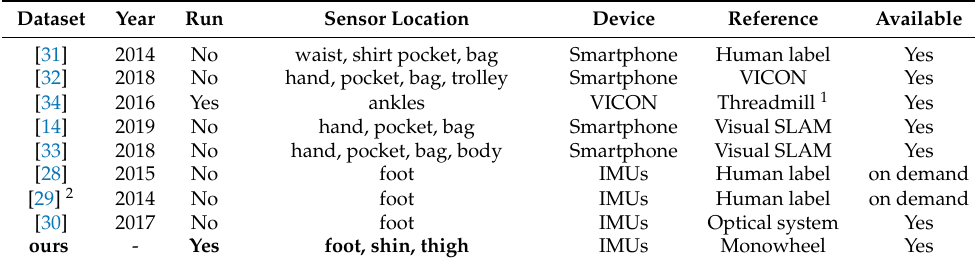
Table 2. Summary of existing datasets for human motion speed estimation.